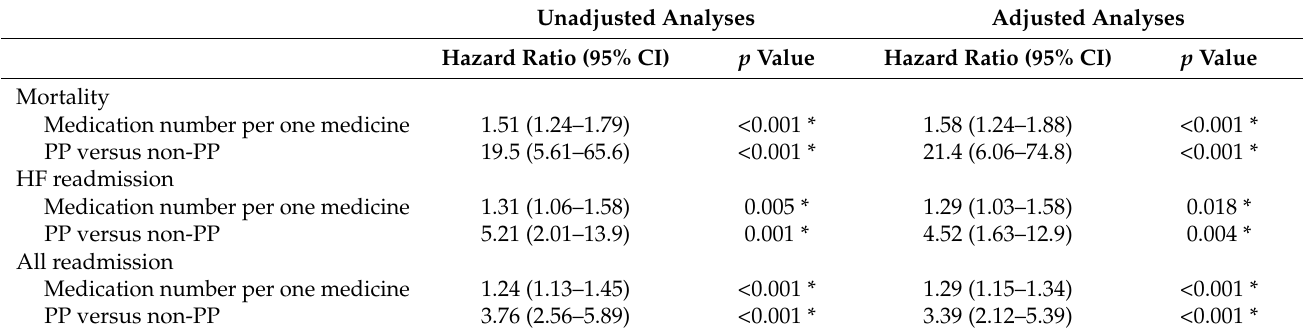
Table 3. Impact of polypharmacy on 2-year